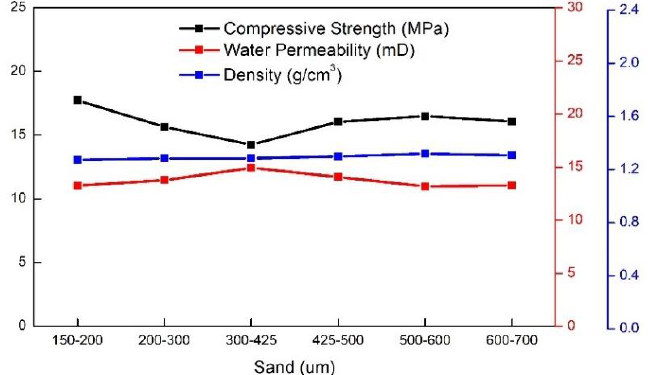
Figure 7. Effect of different particle sizes of sand on the performance of permeable cement stone.